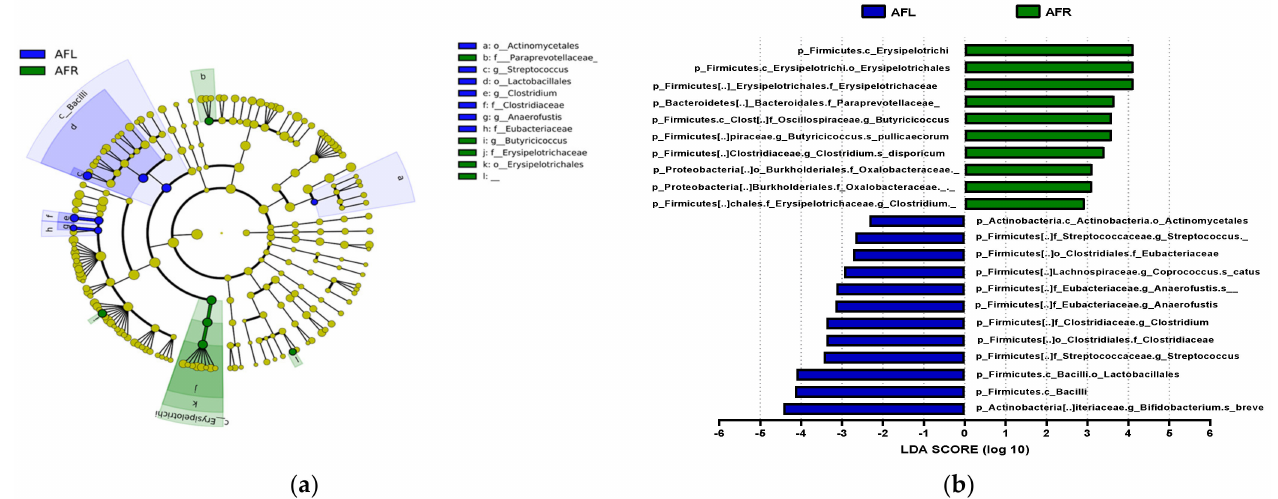
Figure 6. Differences between the taxonomic composition of after flavonoid-low orange juice group and flavonoid-rich orange cordial group intervention in depression. Lefse ( a ) and LDA analysis score ( b ) present the differences in the abundance of bacterial taxa after intervention between the flavonoid- low orange juice and flavonoid-rich orange cordial groups, respectively. AFL: after flavonoid-low orange cordial group, AFR: after flavonoid-rich orange juice group. 3.7. Correlations of Differences before and after Interventions in the FR Group According to a Pearson correlation analysis of the orange juice group, B. pullicaecorum was significantly correlated with the propionic acid (r = 0.655, p < 0.05), valeric acid (r = − 0.648,